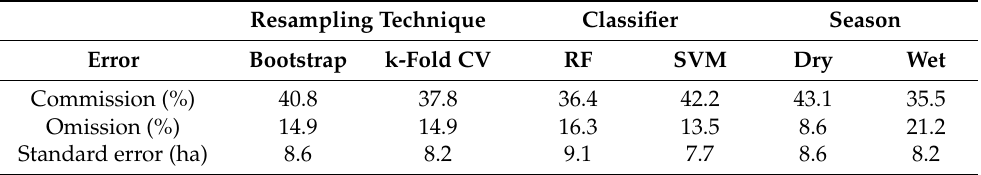
different commission errors, e.g., bootstrapping had 40.8% error of commission compared to 37.8% error for k-fold CV. Table 4. Summary of average error for resampling techniques, classifier, and season (RF: random forest, svm: support vector machine, CV: cross-validation).